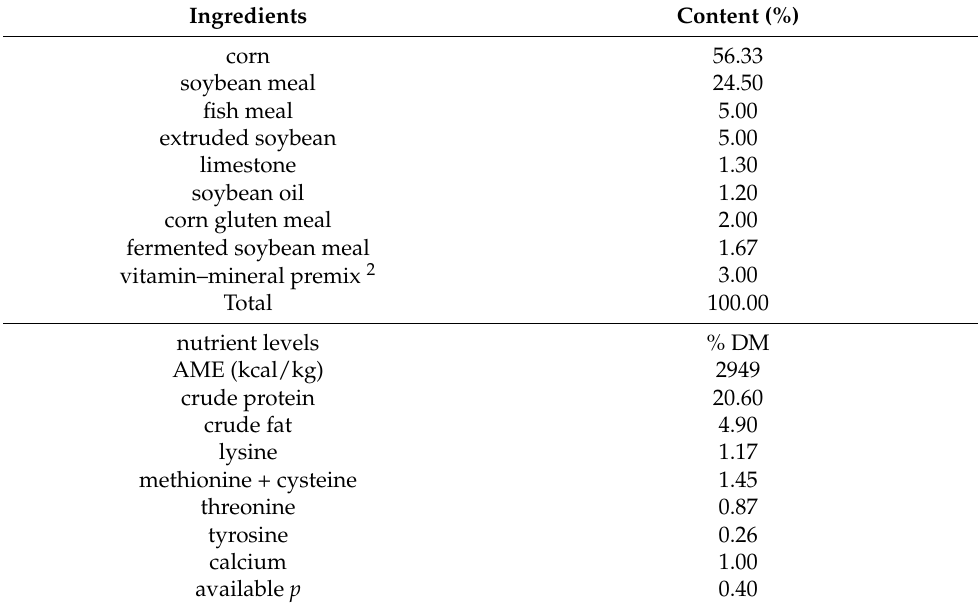
Table 1. Composition and nutrient levels of the basal experimental diet (air-dry basis) 1